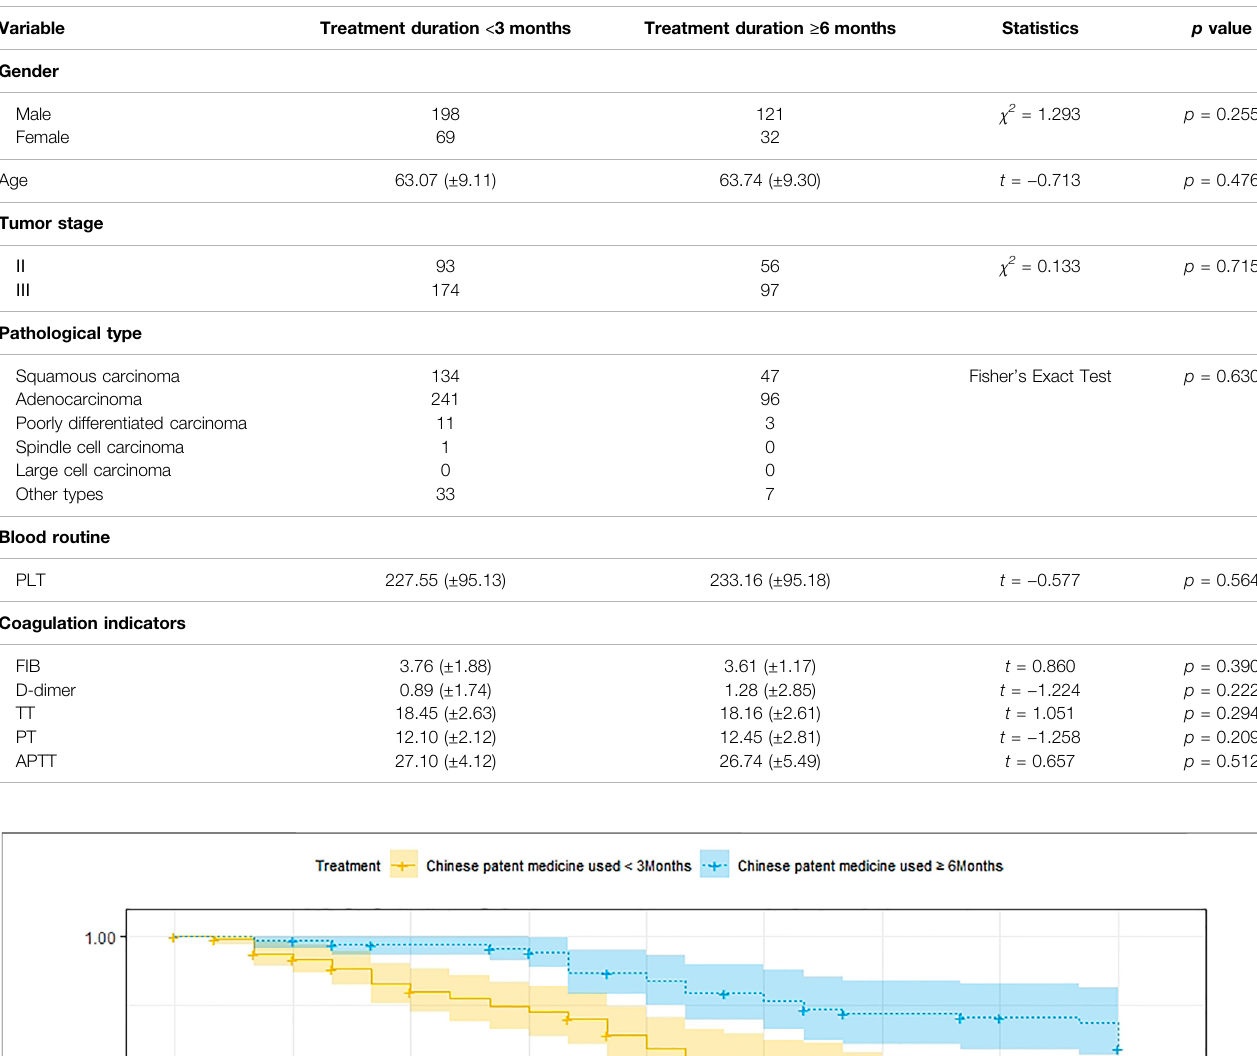
TABLE 3 | Baseline comparison of CPM use for < 3 months and ≥ 6 months group.